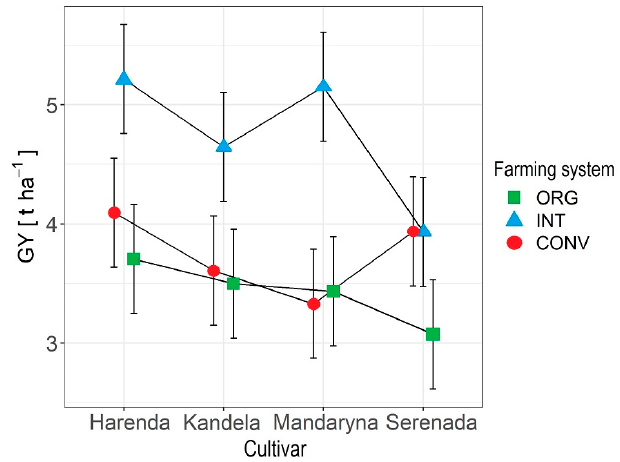
Figure 2 . The interaction effects of cultivar and farming system on GY. Figure 2. The interaction effects of cultivar and farming system on GY.